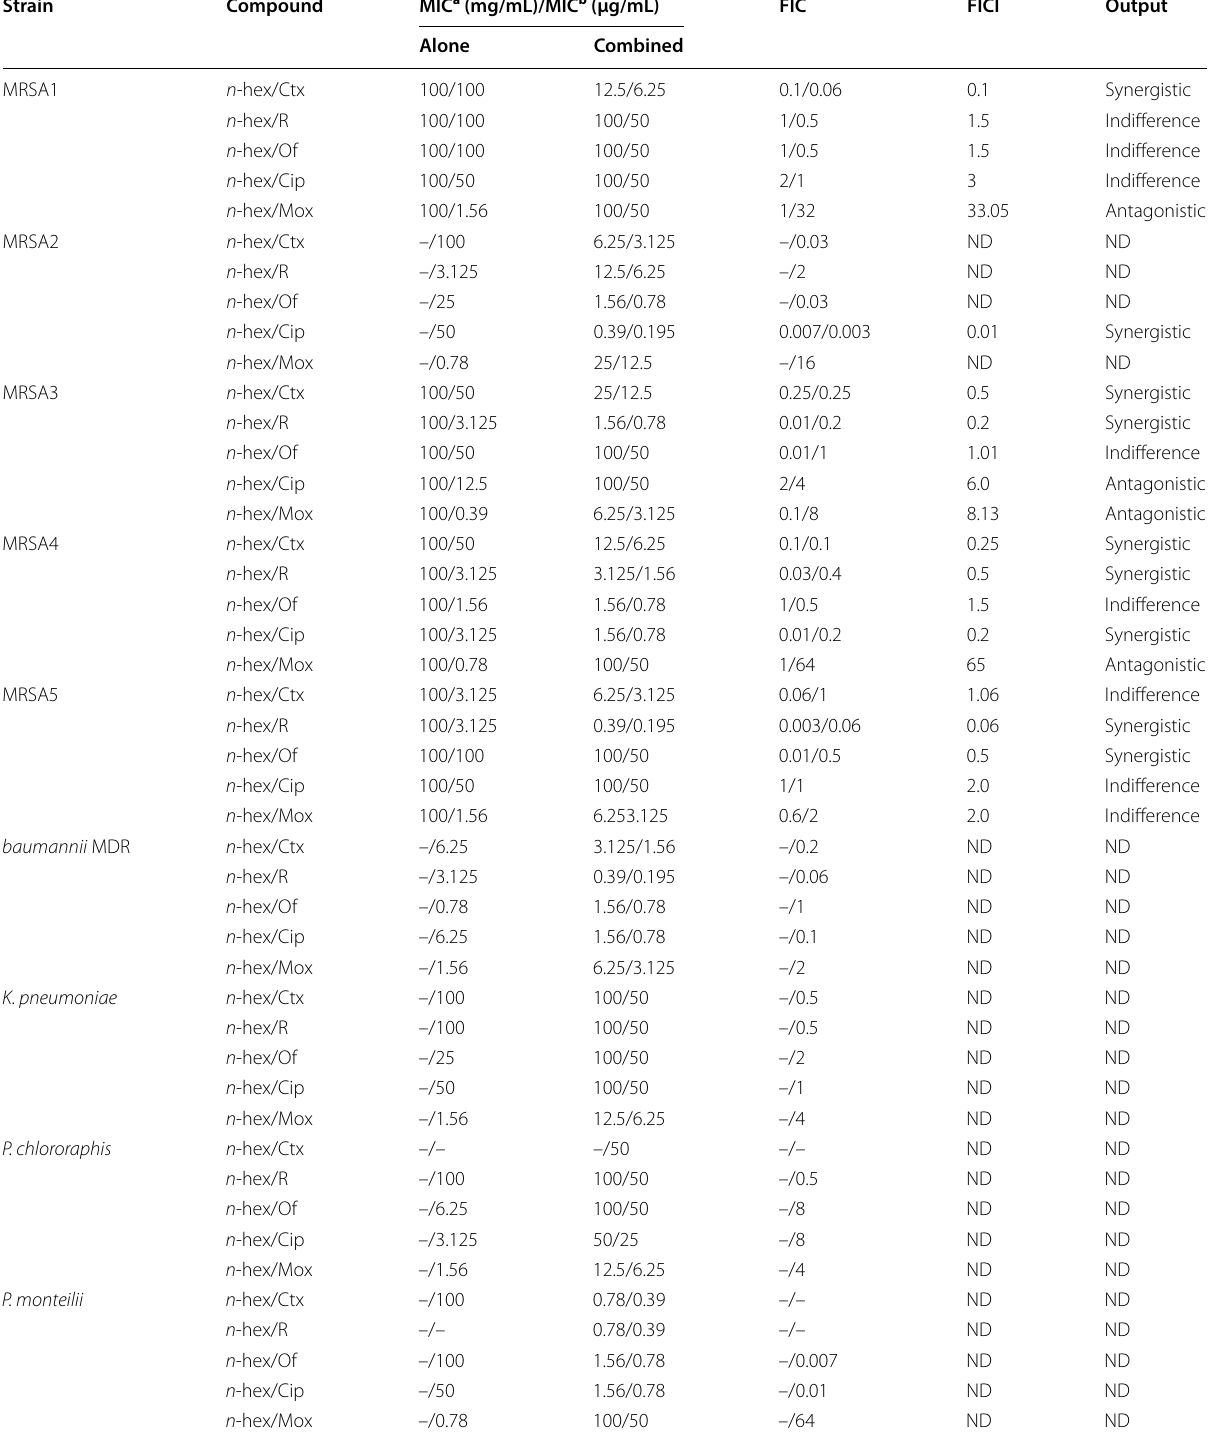
Table 6 Minimum inhibitory concentration (MIC) and fractional inhibitory concentration (FIC) of n -hexane extract, each antibiotic alone and their combination against MDR pathogenic bacterial